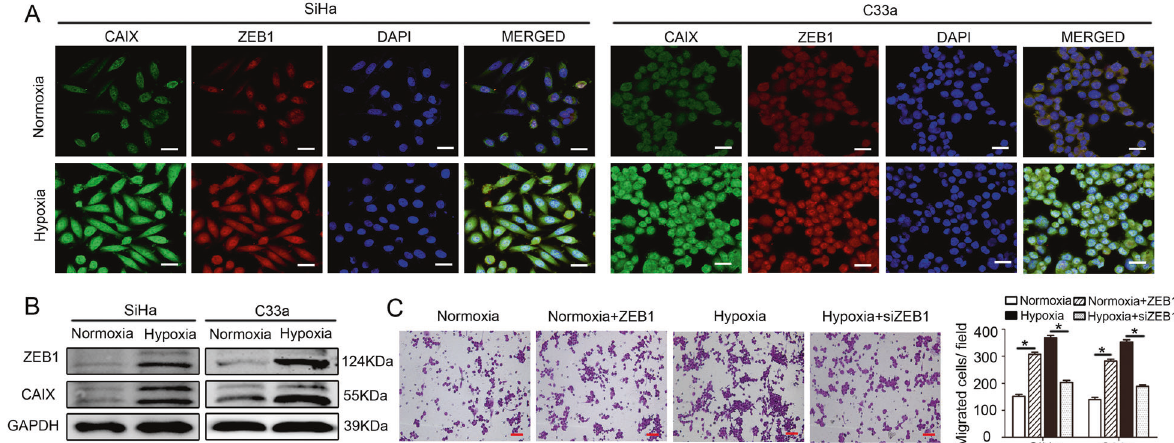
Fig. 2 Hypoxia-induced ZEB1 in cancer cells enhances TAM migration in vitro. a Immuno fl uorescence revealed that hypoxic SiHa and C33a cells exhibited upregulated expression of CAIX (green) and ZEB1 (red). Nuclei were stained with DAPI (blue) (scale bar, 50 μ m). b Western blotting shows that the protein levels of both ZEB1 (upper panel) and CAIX (middle panel) were higher in hypoxic cancer cells than in normoxic cancer cells (left panel shows SiHa cells; right panel shows C33a cells). c The effect of conditioned media (CM) from hypoxia-treated cervical cancer cells on THP-1 cells was detected by transwell migration assay. Scale bar, 50 μ m. * P < 0.05 by Student ’ s t